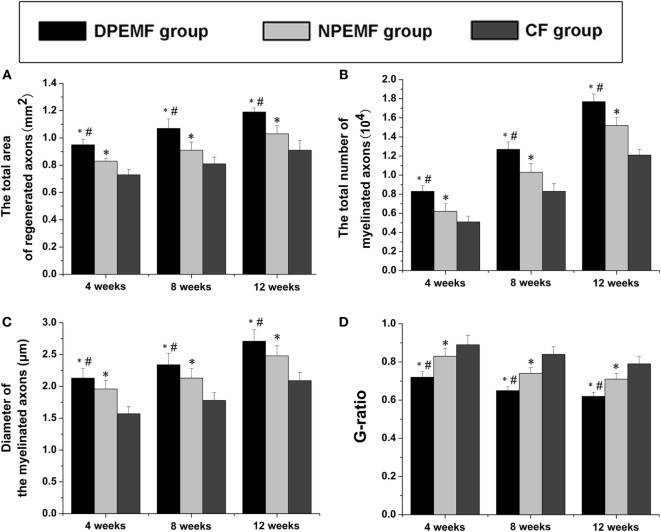
Morphometric assessments of regenerated nerves in each group. The cross-sectional area of regenerated nerve (A), quantification of the myelinated axons (B), the diameter of myelinated axons (C), and G-ratios (D) in the midst portion of conduit (A–D). All data were expressed as the mean ± SEM. *p < 0.05 for comparison with CF group, #p < 0.05 for comparison with NPEMF group.